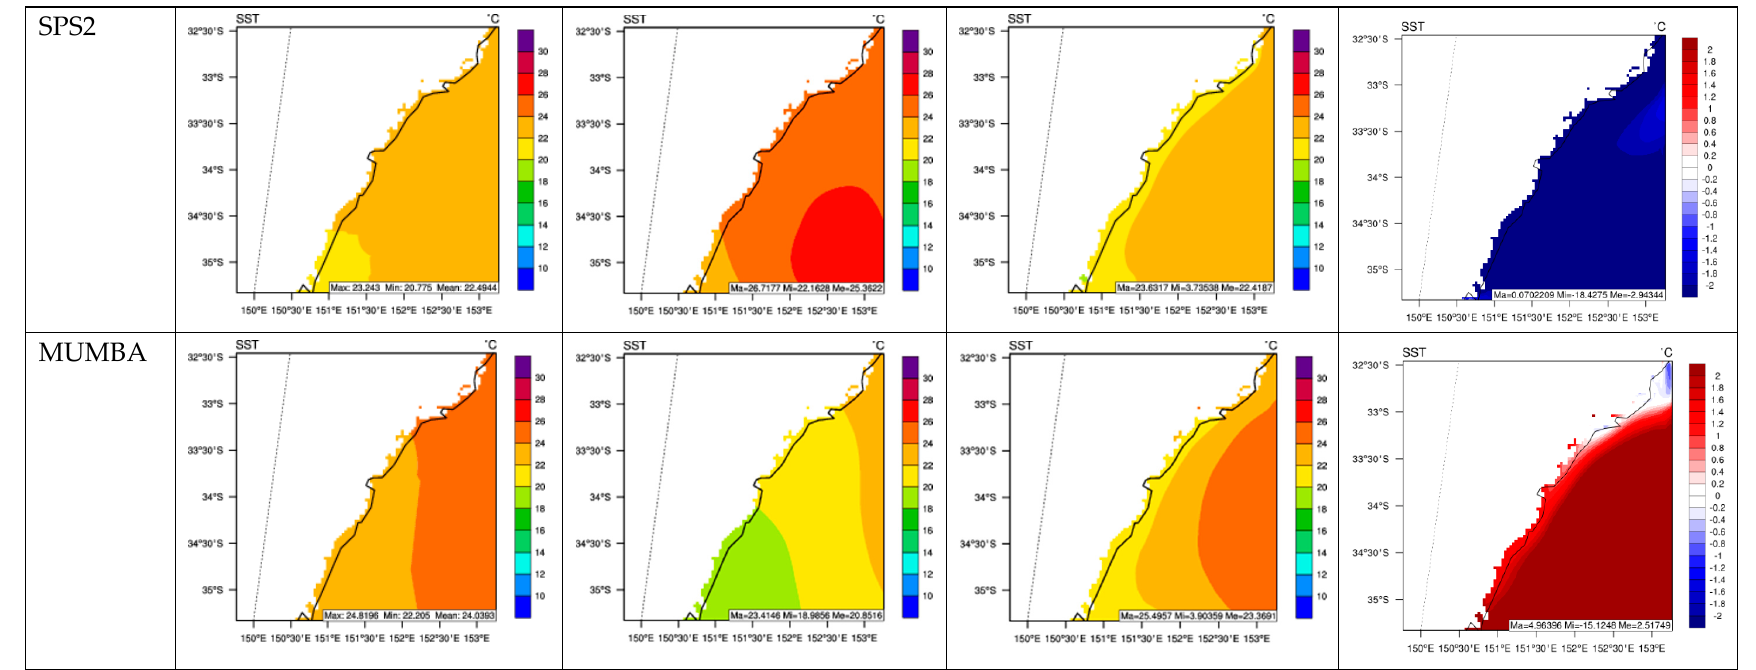
Figure 2. Observed and simulated SST over the Greater Sydney (d04). Two sets of simulation results at 3 km are compared, one from WRF/Chem-NCSU and one from WRF/Chem-ROMS.